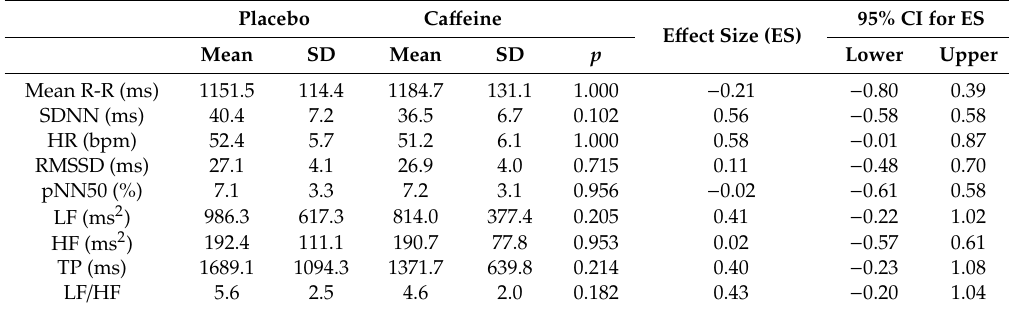
Table 3. Heart rate variability results during the night after placebo or ca ff eine